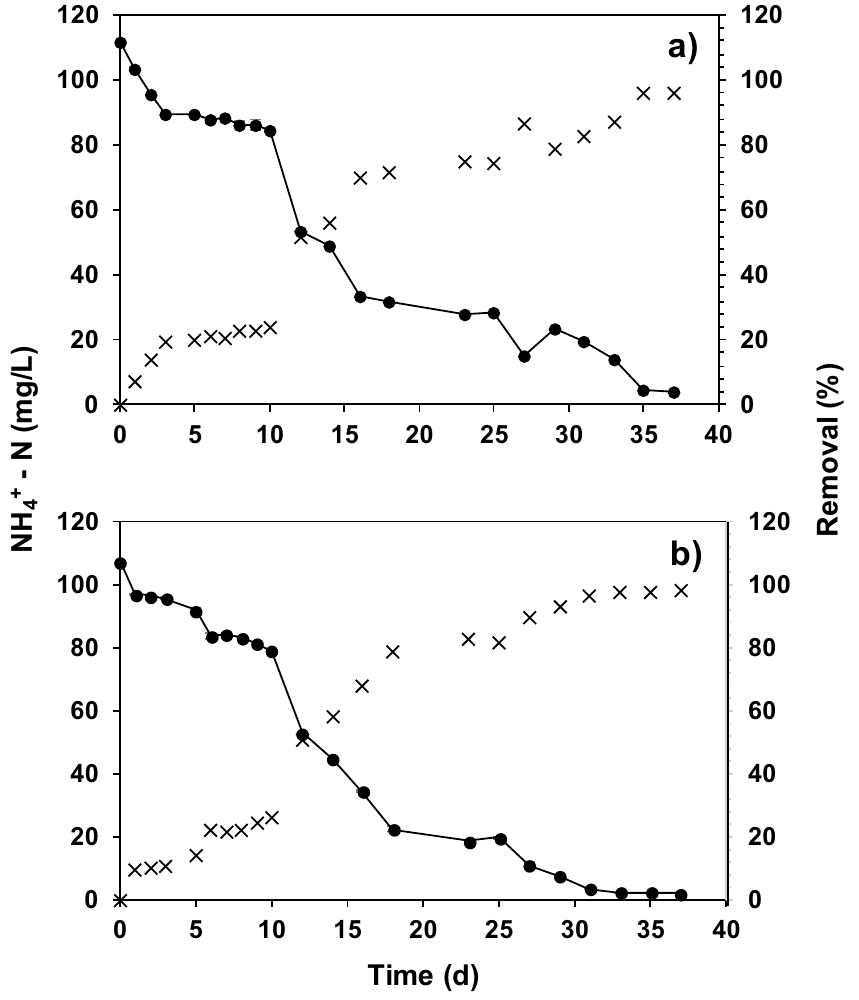
Figure 4. Behavior of NH 4 + -N concentration in suspended and fixed biomass assays (SB + FB), where: ( a ) R1 is polyurethane foam ( b ) R2 is polyethylene rings. (X ) removal efficiency follow-up of mg NH 4 + -N/L (filled